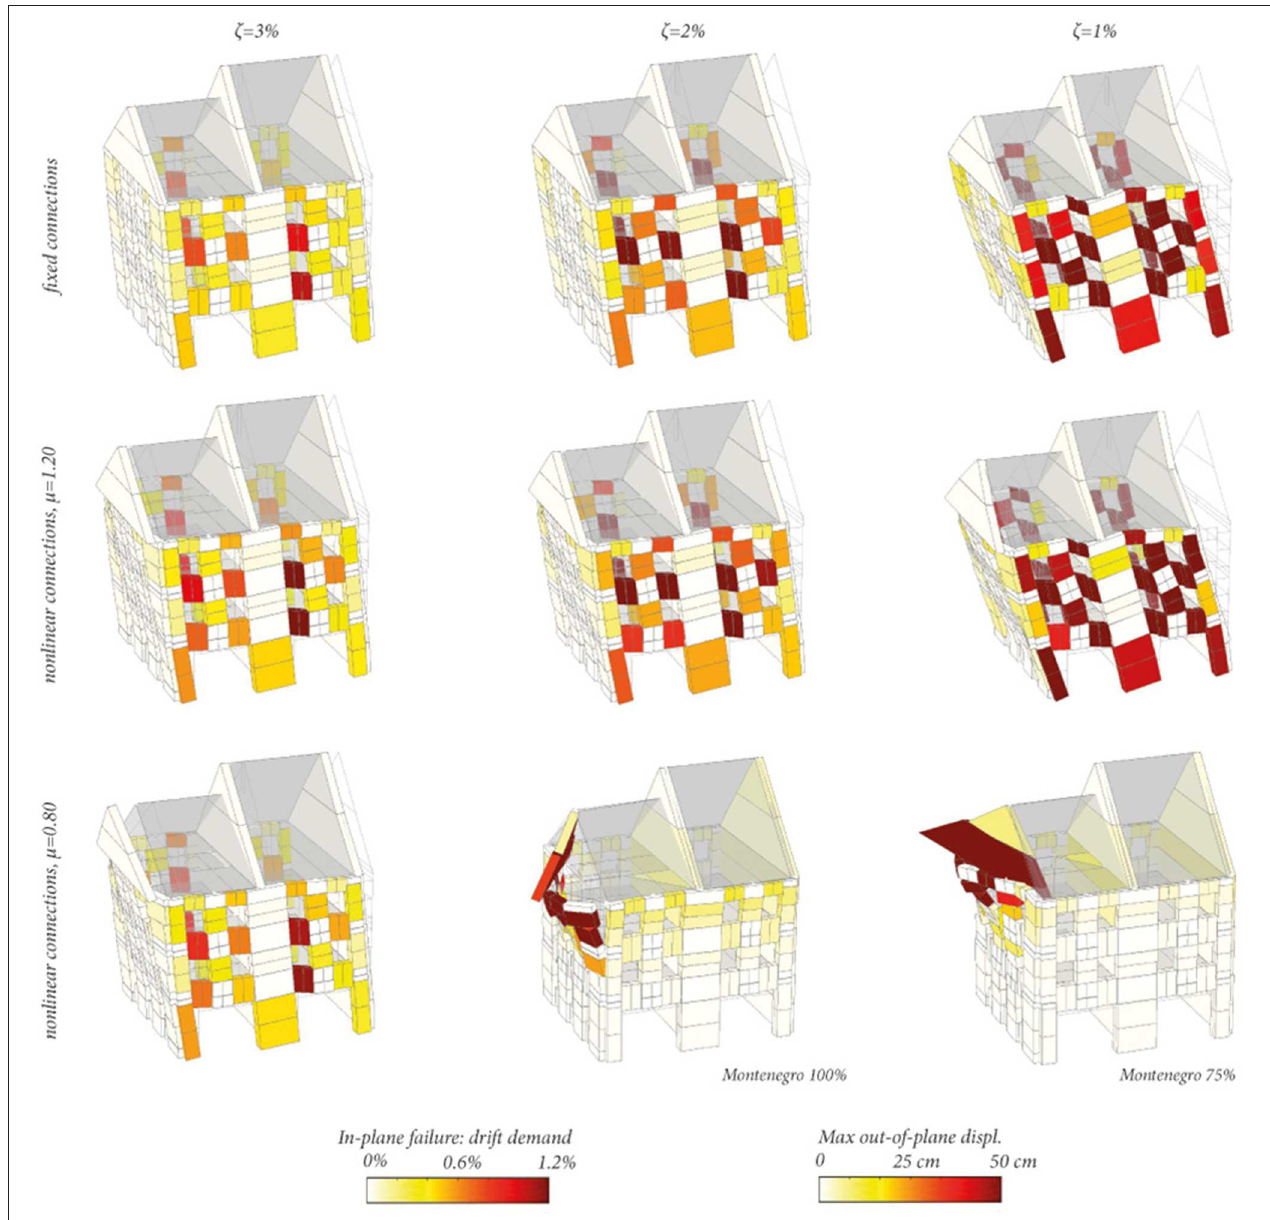
FIGURE 5 | Stone masonry building: sensitivity of failure modes to the effectiveness of floor-to-wall connections and to the damping ratio ζ . Deformation scale: 25 (in-plane failure modes), 1 (out-of-plane